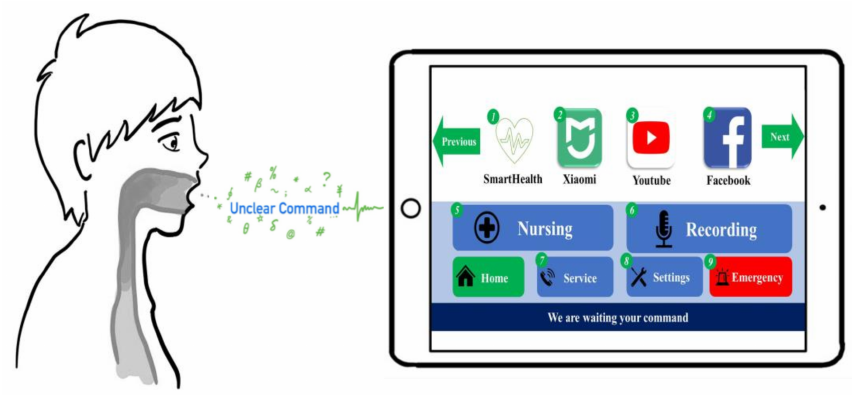
Figure 5. An example of the processed SCR system for dysarthric speakers. Users can maneuver through number commands to select the program they want to use or the help they need. The green area is the item that can be controlled by voice